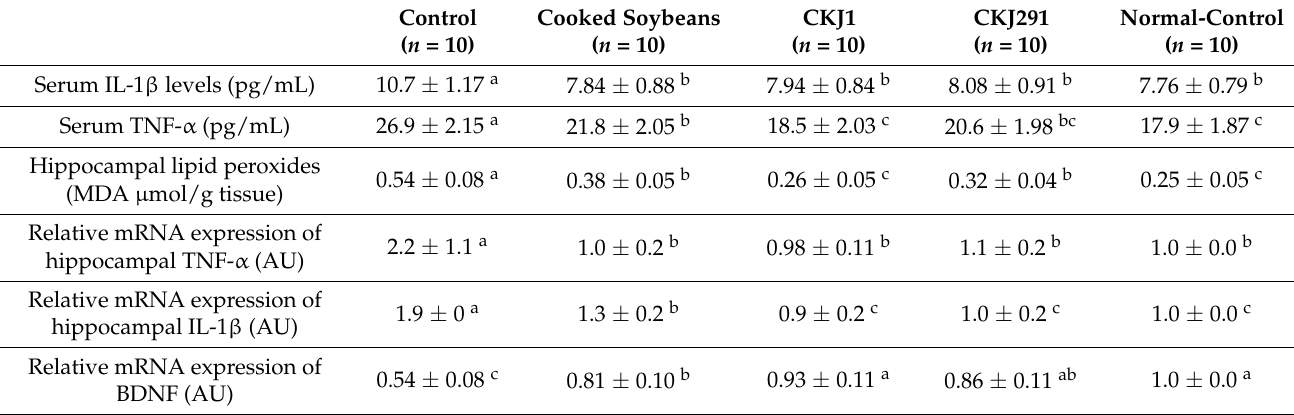
Values are means ± SD ( n = 10). a,b,c values in the same row with different superscript letters were significantly different by Tukey’s test at p < 0.05. AU, arbitrary unit; MDA, malondialdehyde; TNF- α , tumor necrosis factor- α ; IL-1 β , interleukin-1 β ; BDNF, brain-derived neurotrophic